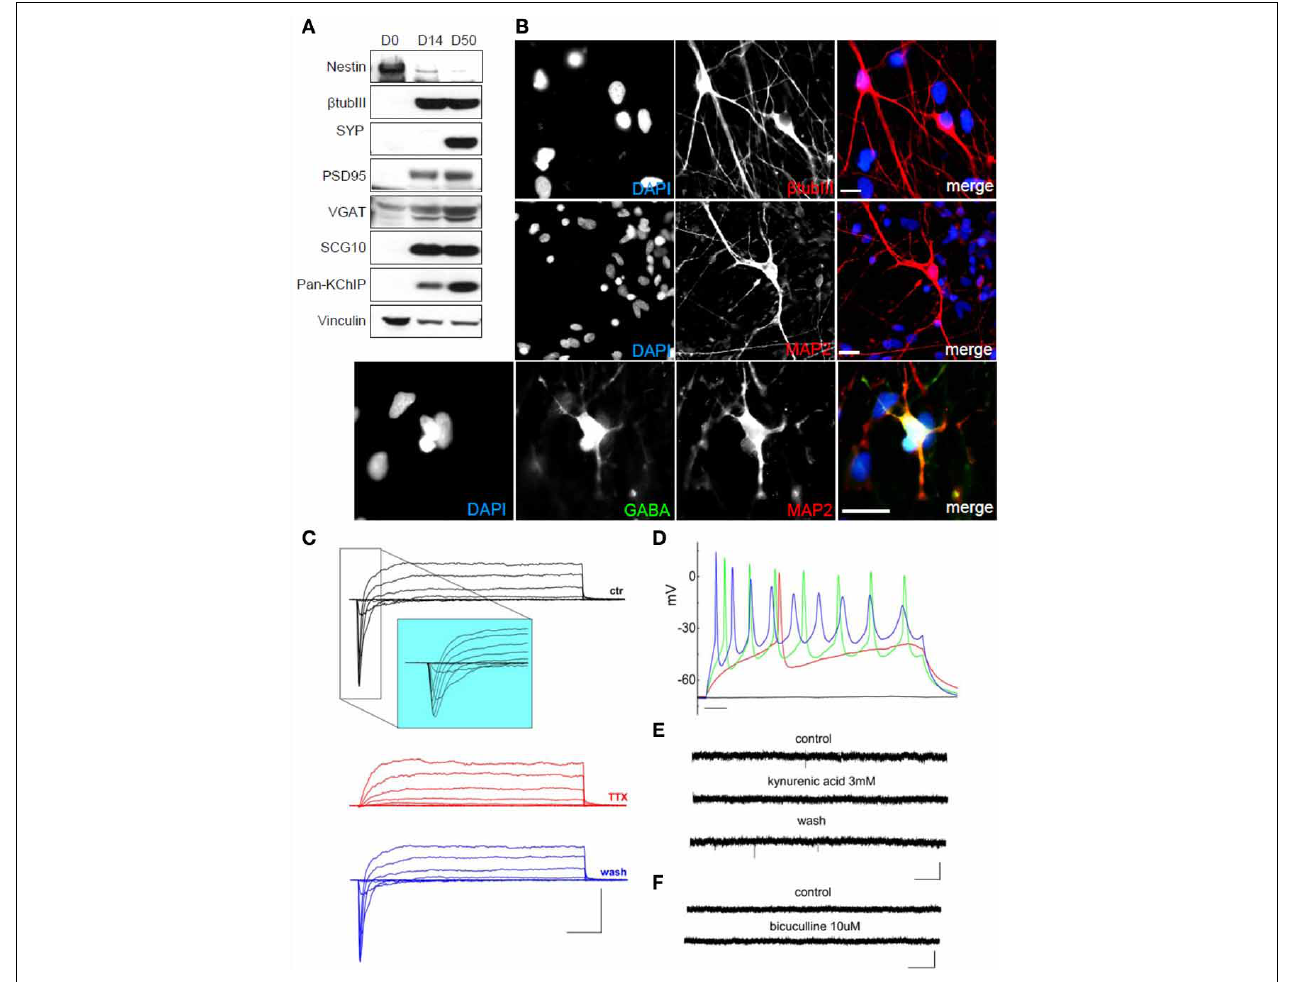
FIGURE 5 | Characterization of hNPC-derived neurons grown on matrigel in differentiation medium. (A) During differentiation of hNPs, the neural precursor marker Nestin is downregulated while the neuronal marker β TubIII is upregulated. hNP-derived neurons express the pre-synaptic marker synaptophysin, the postsynaptic marker PSD-95, the inhibitory synapse marker VGAT, the neuronal growth-associated protein SCG10 and the K + channel interacting proteins KChIP. (B) hNP-derived neurons are positive for the neuronal markers β TubIII (red, top), MAP2 (red, middle and bottom) and GABA (green). Scale bar, 20 μ m. (C) Representative total ionic current traces recorded with depolarizing voltage steps between − 70 and + 10mV (10mV increments from a holding potential of − 70mV) from hNP-derived neurons. From top to bottom: currents in control (black), with perfusion of tetrodotoxin 1 μ M (red) and after washout (blue). Scale bars, 10ms, 500pA. The inset